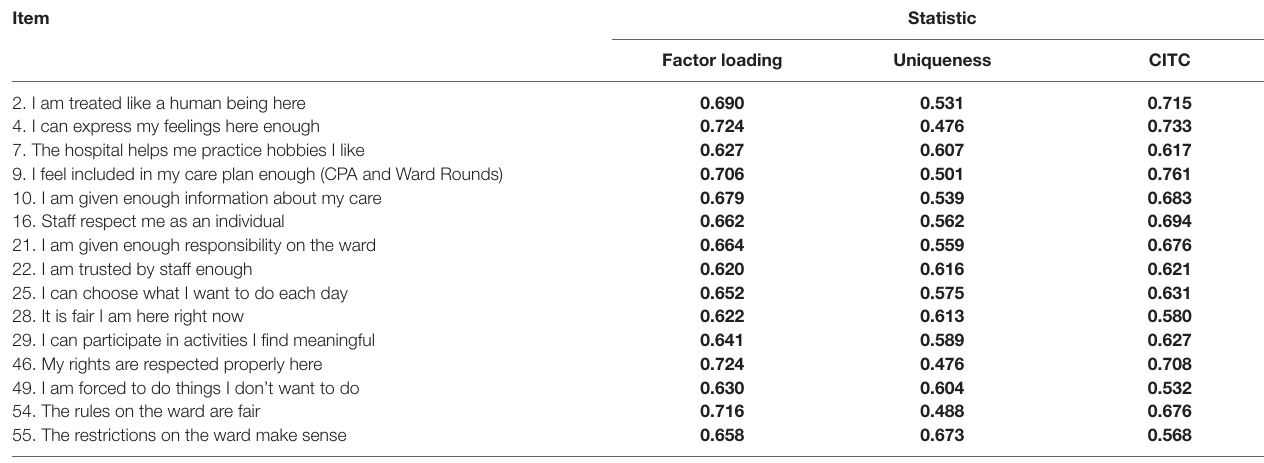
TaBle 3 | Item factor loadings, uniqueness, and CITC scores for the 15-Item FRQ. Item